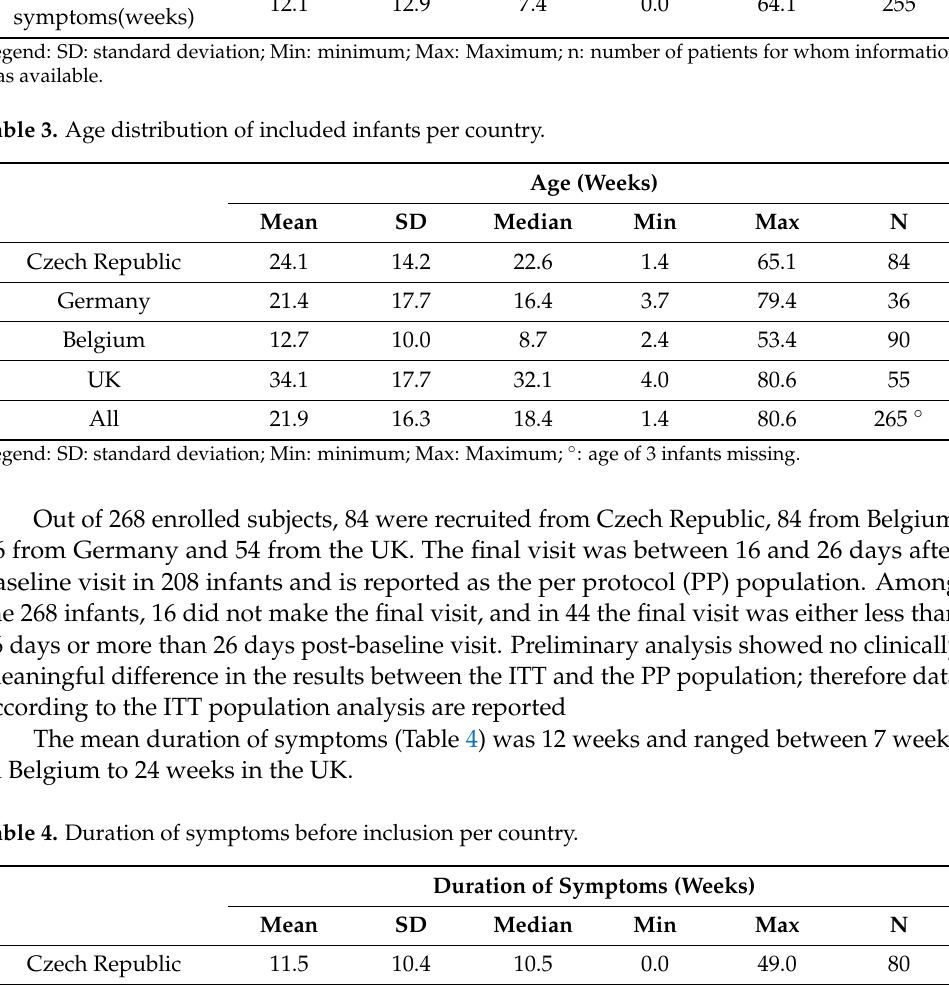
Table 4. Duration of symptoms before inclusion per country.